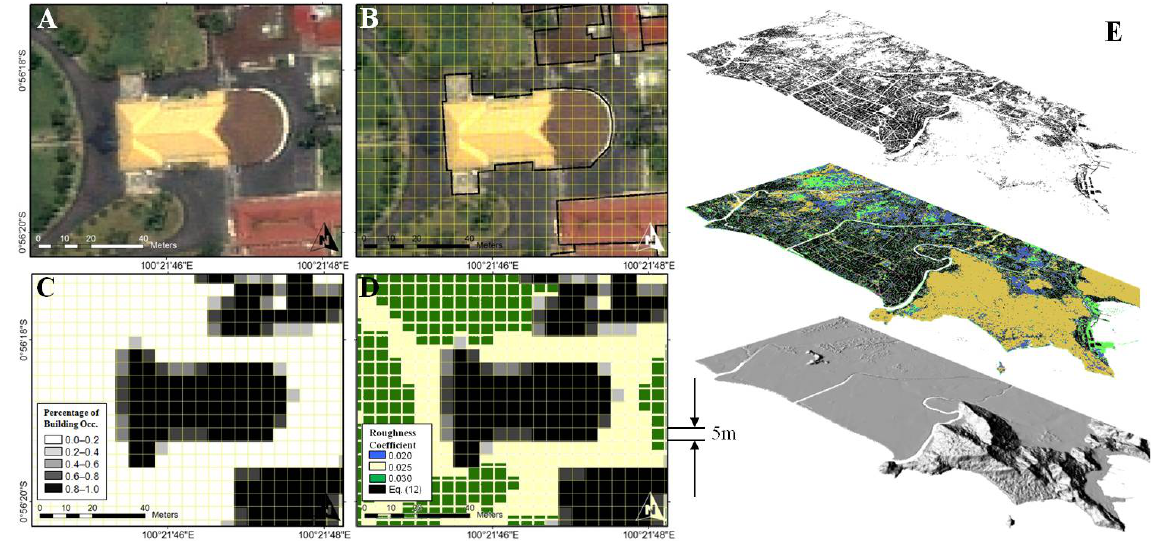
Fig. 9. The process of input data preparation for Equivalent Roughness Model. Color legend in panel D refers to the entire roughness data in the middle figure on panel